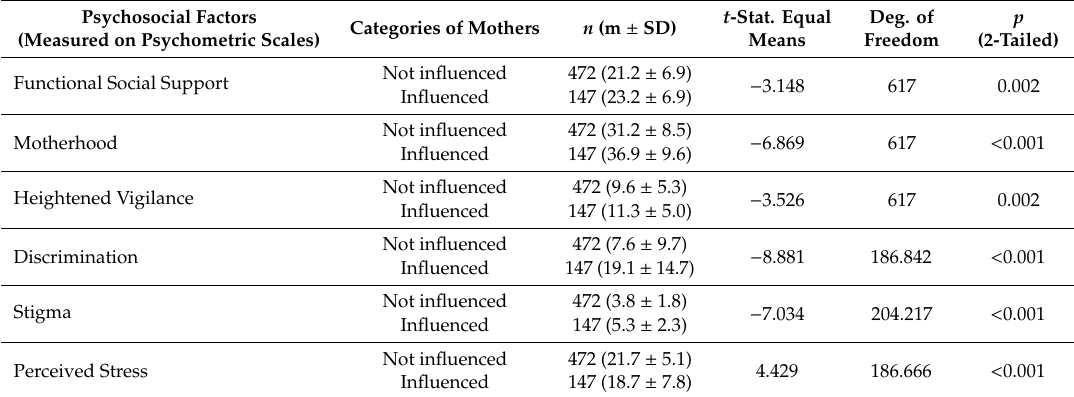
Table 3. Comparison of psychosocial experiences of mothers influenced by cultural beliefs in their infant feeding practices versus those not